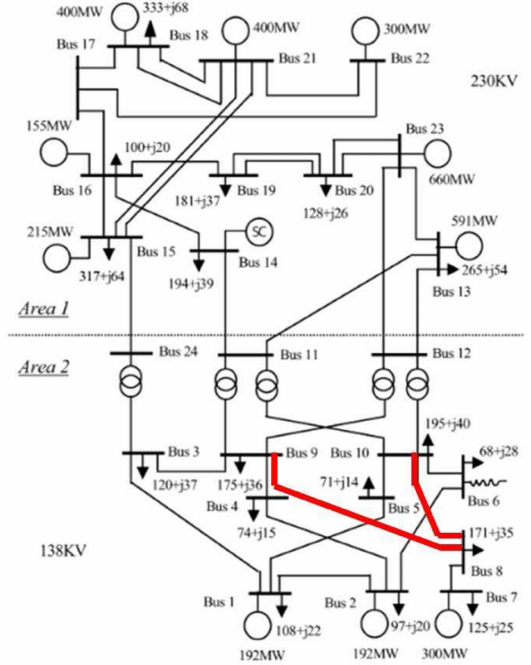
Figure 2. IEEE 24-bus reliability test system. The lines equipped with DLR are highlighted in